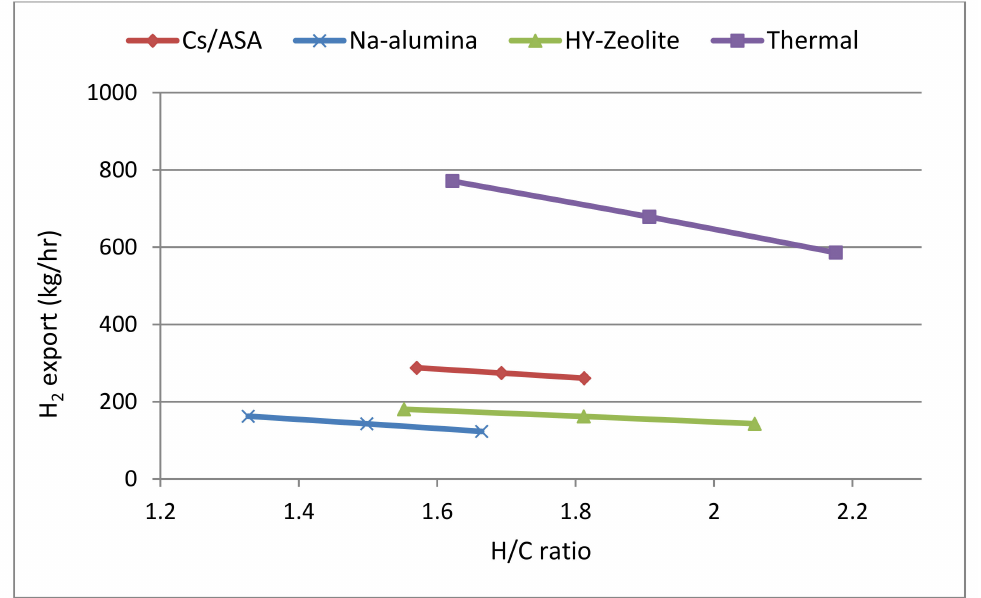
Figure 6. Correlation between H / C ratio and H 2 export; H / C ratio is estimated based on the assumption for number of moles of H 2 added to oil per molecule of ‘O’ removed. The values in the graph are calculated for 0% target oxygen content in final hydrotreated